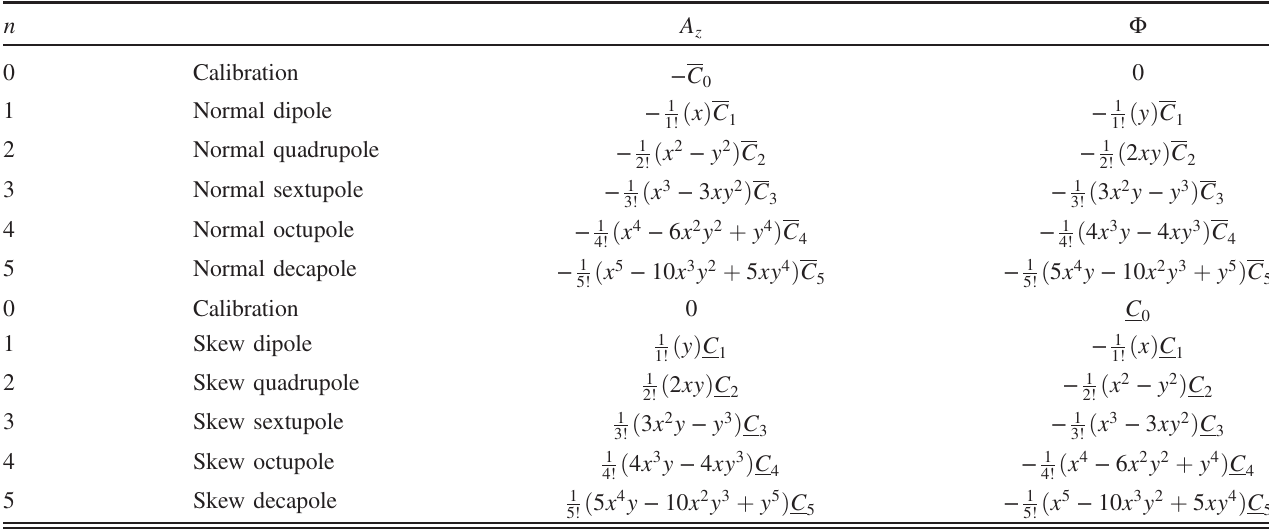
TABLE IX. Longitudinal component of the vector potential and scalar potential for pure normal and skew